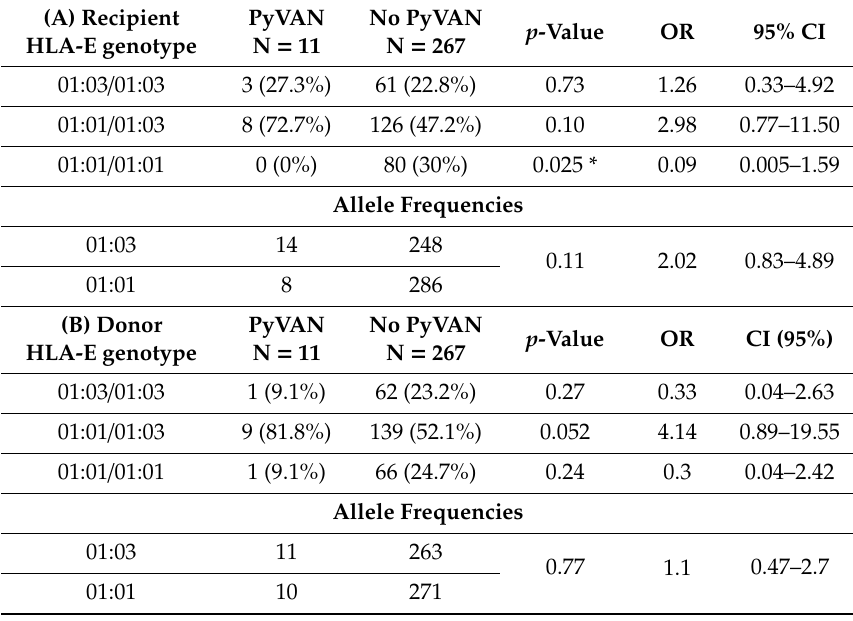
Table 7. Genotype distribution of allele frequencies of HLA-E polymorphism in living-donor kidney transplant recipients (A) and corresponding donors (B) with respect to BK polyomavirus nephropathy (PyVAN).